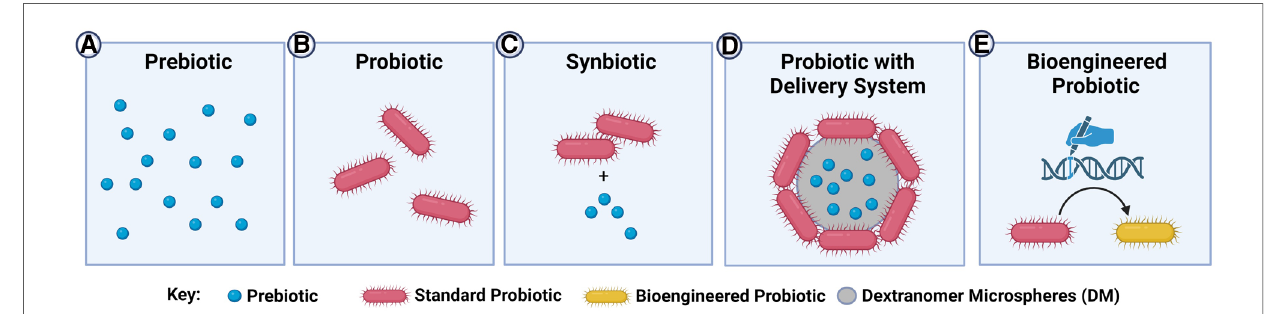
FIGURE 2 Current and next-generation probiotic-related therapies in the prevention of NEC. ( A ) Prebiotics are substrates that bacteria can utilize to confer a health bene fi t to the host. Since no bacteria are administered, this strategy eliminates concerns about probiotic sepsis. However, there are limited pathways being targeted compared to the complex interactions resulting from the use of whole bacteria; ( B ) probiotics are live bacterial species that confer a health bene fi t to the host. These products have a much broader range of targets/effects than simple prebiotics, but there is a theoretical risk of probiotic sepsis; ( C ) synbiotics are probiotics that are co-administered with bene fi cial prebiotics. The prebiotics can enhance the effect of the probiotic, however the prebiotic may not exclusively be used by the probiotic itself and could be utilized by other intestinal bacteria; ( D ) probiotics can be administered using novel delivery systems such as dextranomer microspheres (DM), which can be pre-loaded with prebiotics. These delivery systems can promote the formation of a bio fi lm, leading to increased attachment of the probiotic to the intestinal mucosa. Administration in the bio fi lm state improves survival of the probiotic against the harsh gastric and intestinal environment. The prebiotic and probiotic are co-localized to ensure maximal use of the prebiotic by the adherent probiotics, with no-off target effects of the prebiotic on other microbes; ( E ) bioengineered probiotics are theoretical or emerging probiotics in which speci fi c pathways are enhanced or altered through bioengineering strategies. This can theoretically reduce safety concerns by eliminating pathogenicity and improve ef fi cacy by selecting bene fi cial phenotypes. However, signi fi cant regulatory hurdles for the development and testing of bioengineered probiotics exist at